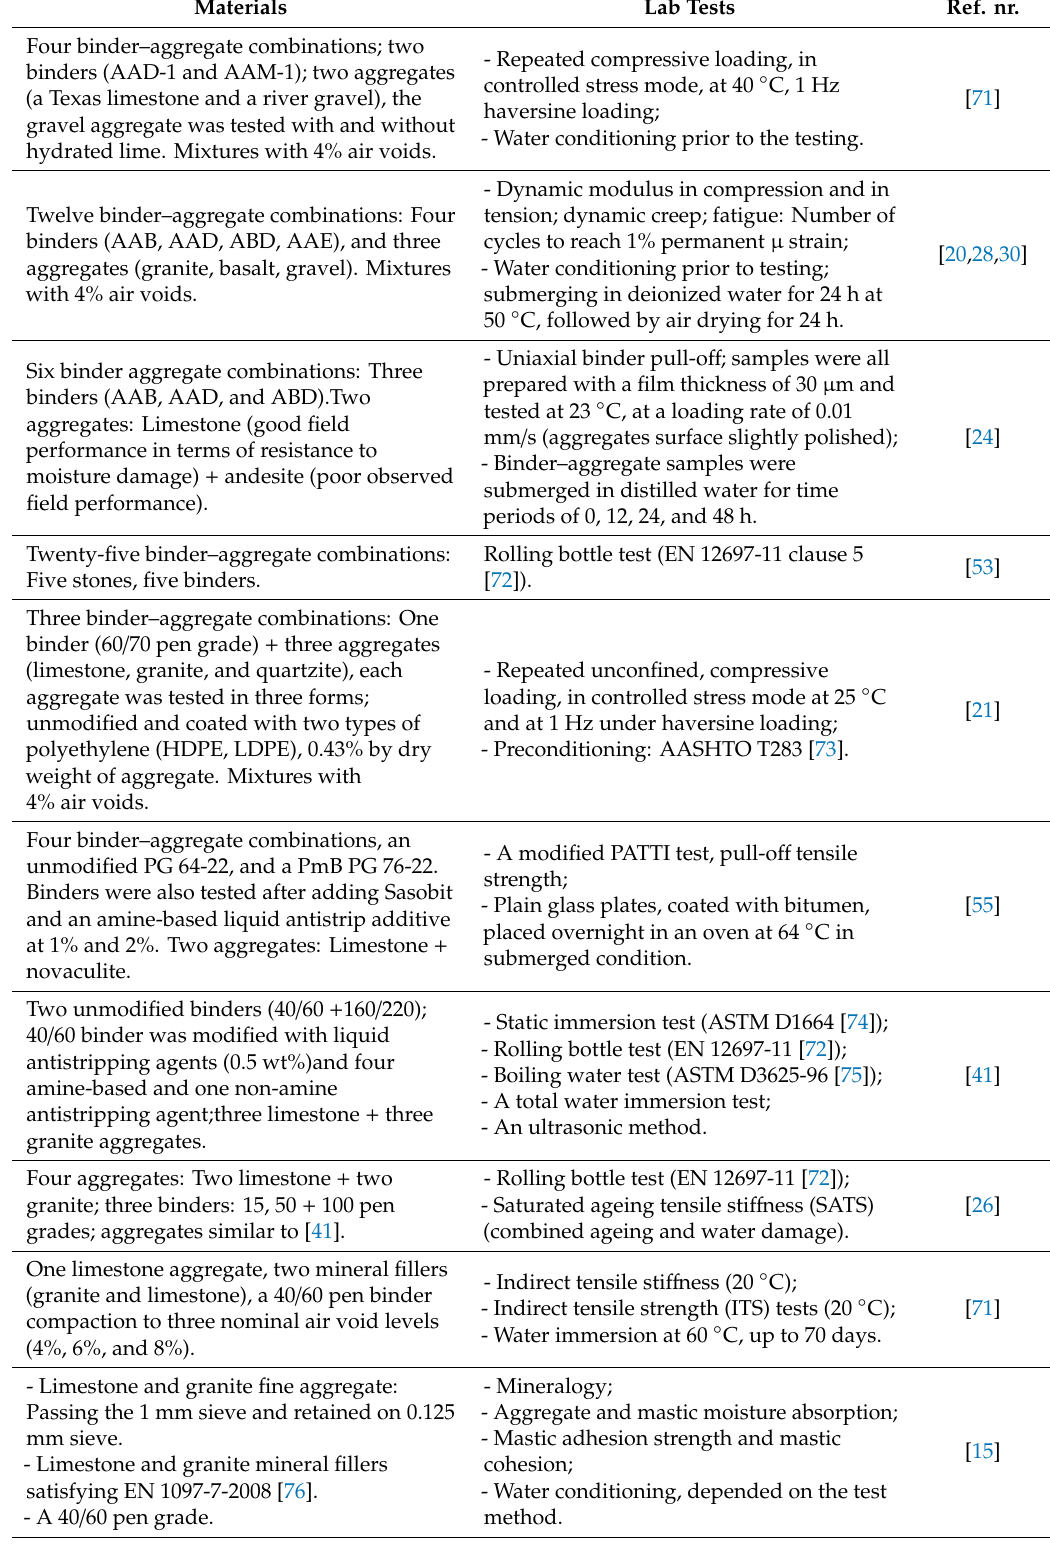
Table 4. Overview of papers investigating relations between laboratory tests and predicted performance based on surface energy calculations (the findings are summarized in the